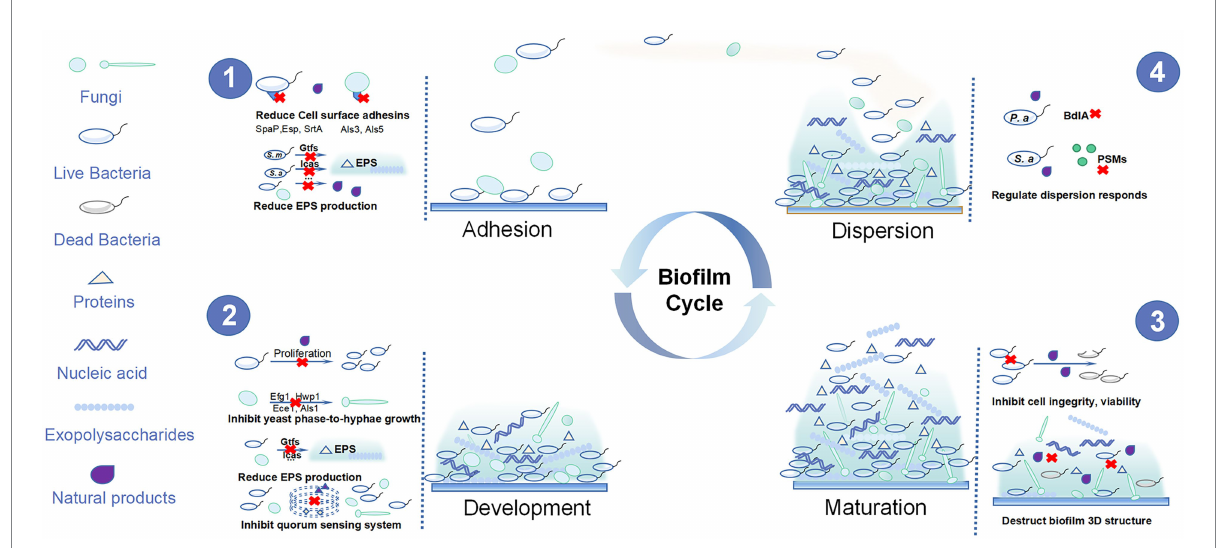
FIGURE 1 The four steps of oral biofilm formation and the anti-oral biofilm targets of natural